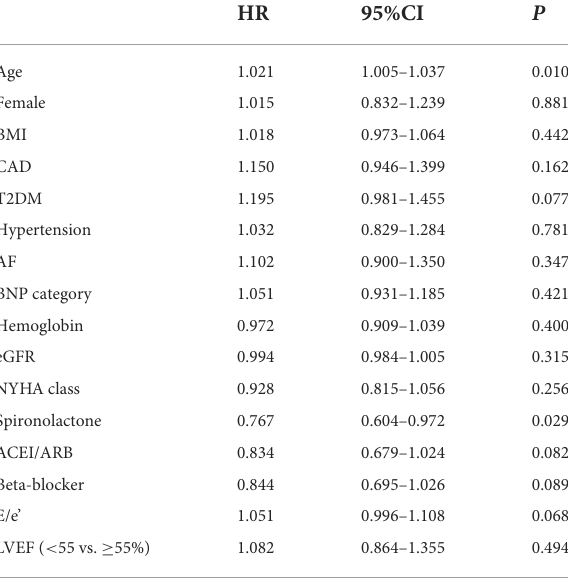
TABLE 5 Multivariable Cox analysis for composite endpoints in HFpEF patients with LVEF <